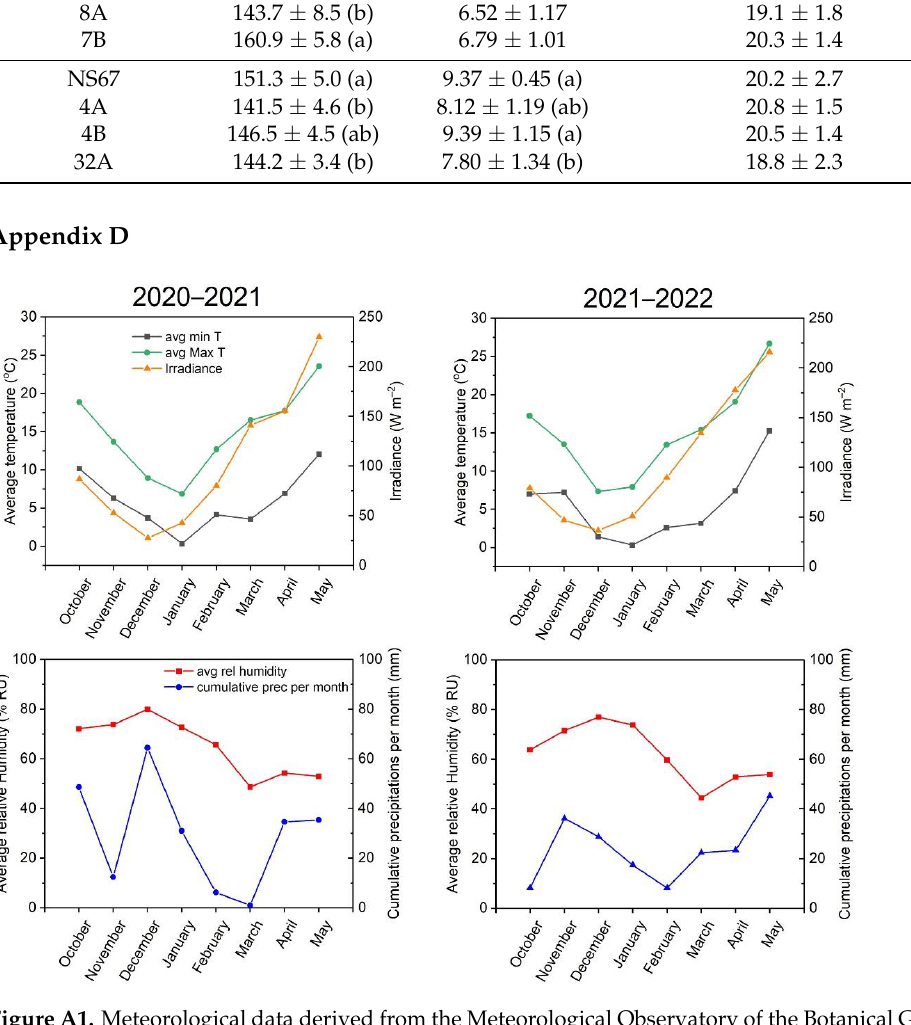
Figure A2. Example of a daily variation in solar radiation reaching the experimental site, as assessed on 20 November 2020, by the Meteorological Observatory of the Botanical Garden of Ferrara, Italy. References 1. Song, P.; Wang, J.; Guo, X.; Yang, W.; Zhao, C. High-throughput phenotyping: Breaking through the bottleneck in future crop breeding. Crop. J. 2021 , 9 , 633 – 645. https://doi.org/10.1016/j.cj.2021.03.015. 2. Yang, W.; Feng, H.; Zhang, X.; Zhang, J.; Doonan, J.H.; Batchelor, W.D.; Xiong, L.; Yan, J. Crop phenomics and high-throughput phenotyping: Past decades, current challenges, and future perspectives. Mol. Plant 2020 , 13 , 187 – 214. https://doi.org/10.1016/j.molp.2020.01.008.